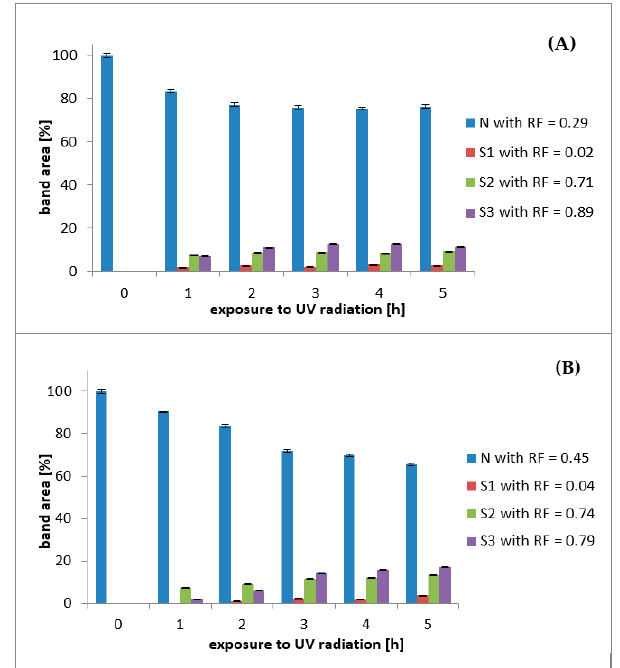
Figure 1. The comparison of area (in %) of chromatographic bands obtained from naproxen (N) irradiated to UV light ( λ = 254 nm) from 1 to 5 h on silica gel and substances (S1–S3) being the main products of chemical degradations of naproxen and the standard of naproxen not exposed to UV light (0 h), mobile phase used: TOL-ACE-CHL (2:5:12, v/v/v) ( A ) and AcOH-Hex-ACE (0.10:10:10, v/v/v) ( B ). S2—naproxen ethyl ester; S1, S3—unknown products of transformation of naproxen.